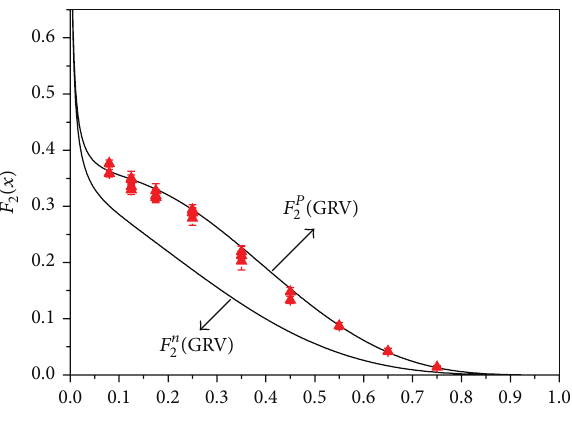
Figure 2: GRV’s free neutron and proton structure function. The experimental data shown for free proton structure function are taken from [19].